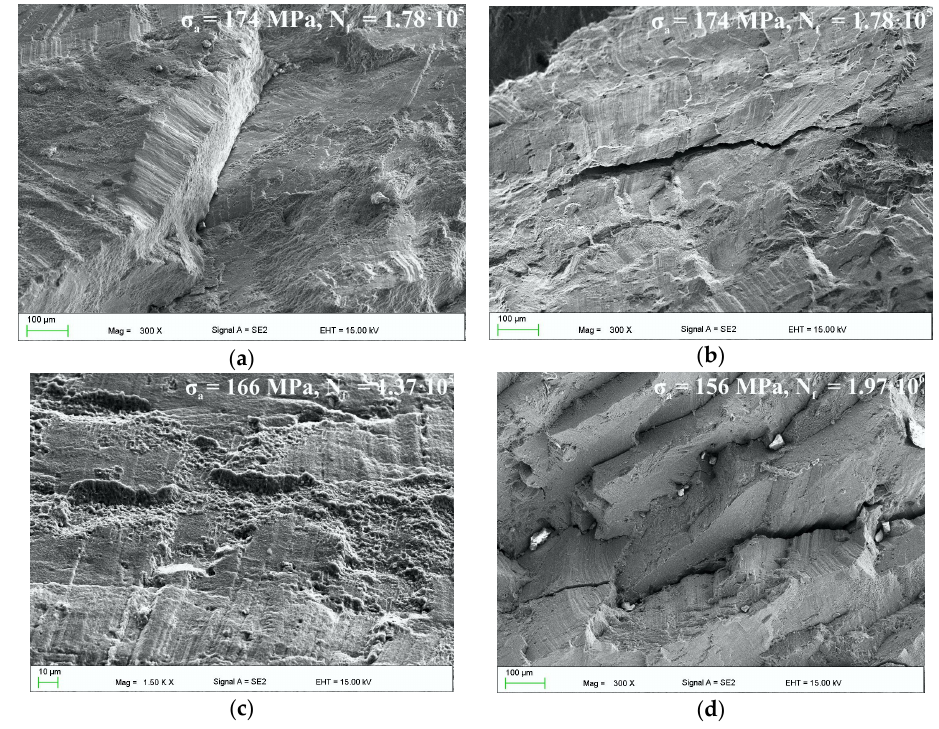
Figure 8. Fractures of fatigue test samples (oscillatory bending) of AlZn6Mg0.8Zr alloy, subjected to supersaturation in water from 500 °C: ( a ) smooth surfaces of jogs of cleavage planes; ( b ) secondary crack in the fracture surface; ( c ) mixed nature of the fracture; ( d ) cracks proceeding along the jogs of cleavage